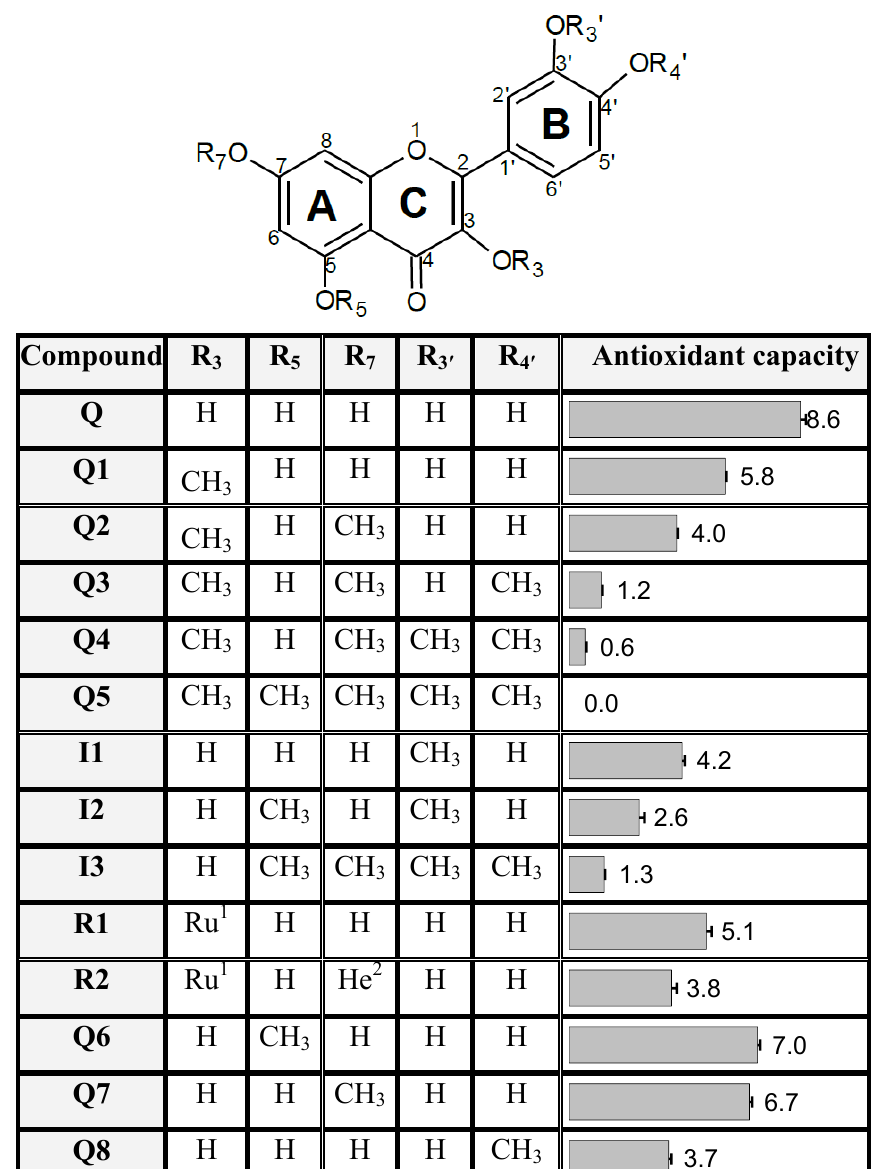
Table 1. The antioxidant capacities of quercetin ( Q ), isorhamnetin ( I1 ), rutin ( R1 ) and their derivatives. The capacity is expressed as the number of ABTS radicals (ABTS is scavenged by one molecule of the tested